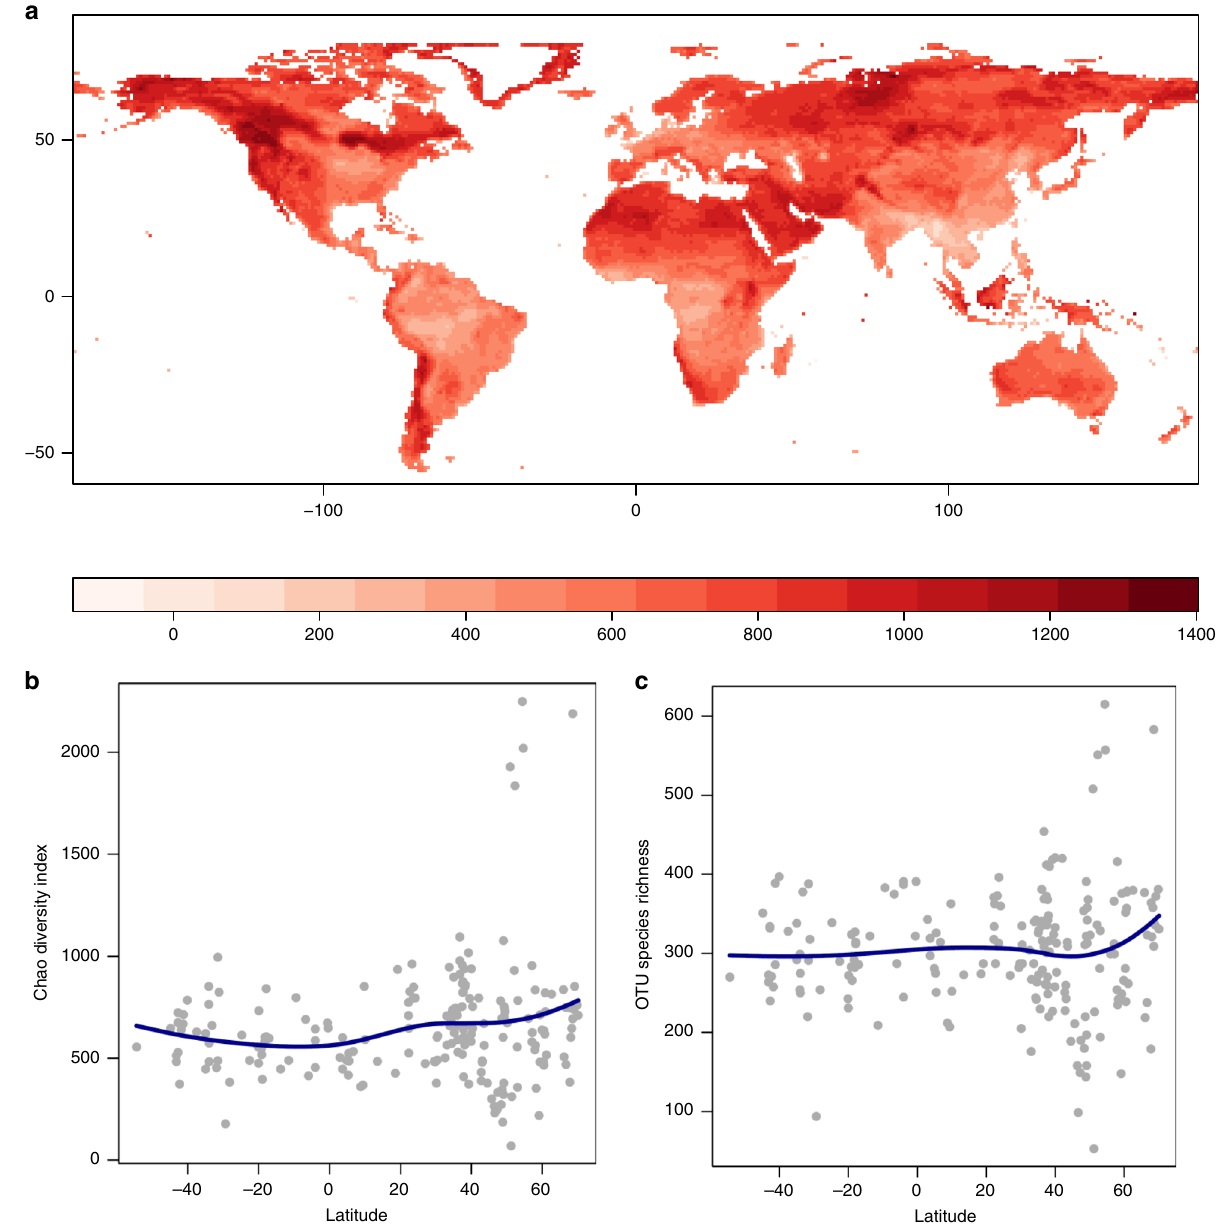
Fig. 5 Inferred patterns of fungal species diversity predicted by the best-subset GLM. a The Chao index of the OTU diversity projection (model R 2 = 17.2%); b latitudinal gradient fi tted by the means of the non-parametric smoothing of the Chao index; c latitudinal gradient fi tted by the means of the non- parametric smoothing of the OTU